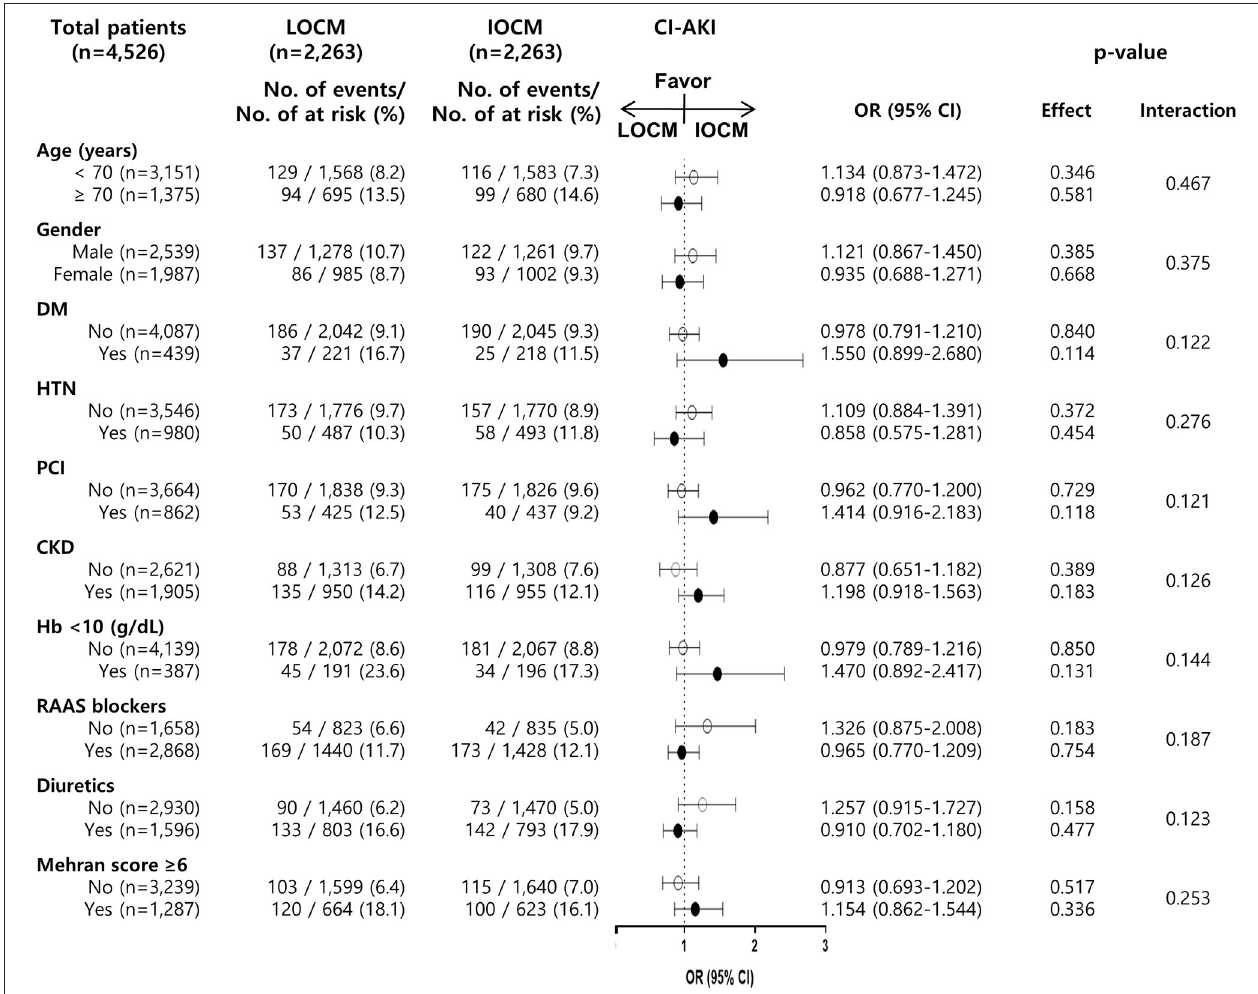
FIGURE 3 | Association of LOCM use and development of CI-AKI in subgroups of the matched cohort. CI-AKI, contrast-induced acute kidney injury; LOCM, low-osmolar contrast media; IOCM, iso-osmolar contrast media; DM, diabetes mellitus; HTN, hypertension; PCI, percutaneous coronary intervention; CKD, chronic kidney disease; Hb, hemoglobin; RAAS blocker, renin-angiotensin-aldosterone system